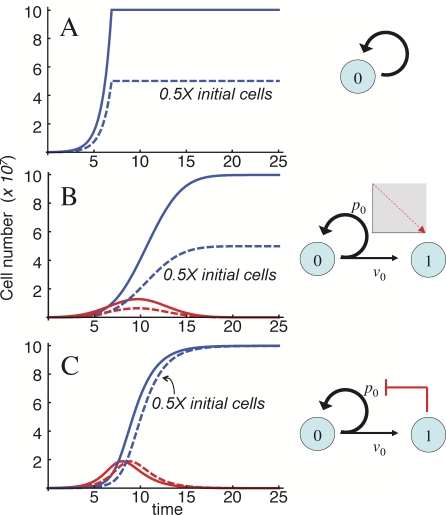
Behaviors of Final-State SystemsThree different ways are shown by which an initial pool of 105 progenitors (solid curves) or 5 × 104 progenitors (dashed curves) can generate 108 terminally differentiated cells. Differences among the three mechanisms are illustrated by the diagrams at right.(A) Simple exponential expansion. The progenitor pool expands for just enough time to produce the desired output and then stops. Halving the starting number of progenitors halves the output.(B) Nowakowski-Caviness system: progenitors undergo both replicative and differentiative divisions, according to a replication probability p
0, which starts at p
max > 0.5 and declines linearly to p
min < 0.5 at time τ. As in (A), halving the initial progenitor cell number halves the output. The output is also highly sensitive to values of p
max and τ.(C) System with negative feedback on p
0. Feedback is modeled as previously, using a Hill function (without cooperativity in this example). Halving the starting progenitor pool now produces almost no change in output (there is, however, a one cell cycle lag in reaching the final state). Sensitivity to p
0 is also reduced.In each panel, time is expressed in units of ln2/v
1. Parameter values were, in (A), time of cessation of cell division = 6.91/v
0; in (B), p
max = 1, p
min = 0, and τ = 19.4; and in (C), p
0 = 0.9, and γ = 3.14 × 108 (where γ is the feedback gain).